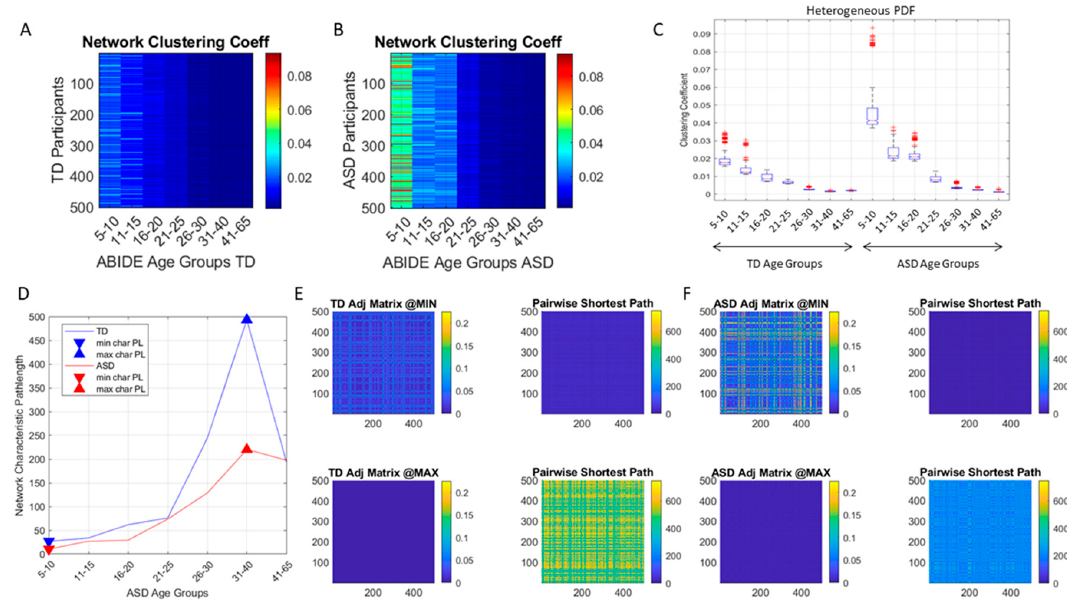
Figure 9. Network connectivity metrics used to separate the two cohorts by age groups and automatically detect significant statistical differences across age groups and between each control and ASD same-age group. ( A ) Values of network’s clustering coefficient for each node (representing a participant) in neurotypical controls distinguish each age group. ( B ) Likewise, the clustering coefficient distinguishes each age group, with higher values in ASD relative to controls. Nodes are more connected in earlier years (up to 20 years of age) in ASD according to the similarity metric of EMD computed pairwise and determining the weighted connected graph of each cohort. ( C ) Non-parametric ANOVA, Kruskal-Wallis test captures the within and between group differences. ( D ) The characteristic pathlength computing the average shortest distance path from all nodes to each node also captures differences within each group and between the two cohorts of typical controls and ASD. Minimum and maximum characteristic pathlength values are shown with corresponding adjacency matrices ( E ) and network distance matrices ( F ) for each cohort.